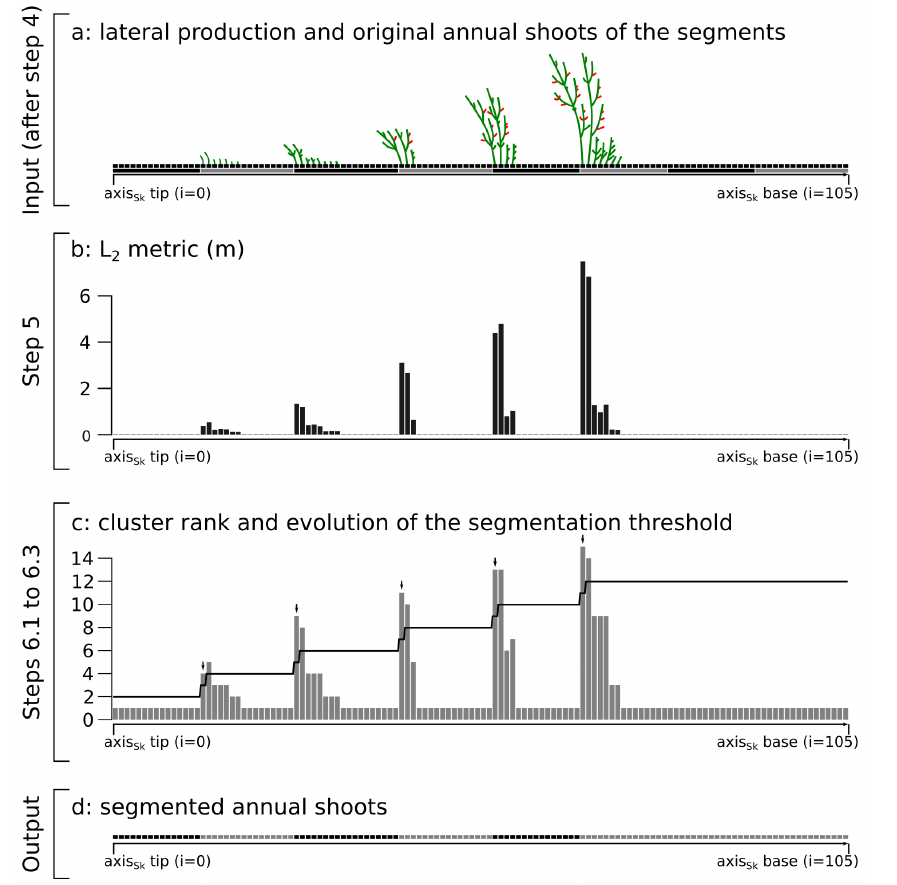
Figure 4. Illustration of the annual shoot segmentation along the trunk of an 8-year-old simulated tree composed of 105 segments. The input data ( a ) consists of a set of segments (dots of a dashed line), here presented with a schematic representation of their child axes Sk (with the axes Sk in green being used in the L 2 metric computation and those in red being excluded). Note that the annual shoots of the main axis are represented by a bicolour line for the purpose of clarity. The L 2 metric of each segment is then computed (bar height in ( b )). The segments are then grouped into clusters based on their L 2 metric, and the clusters are ranked by increasing order of L 2 metric (bar height in ( c )). An evolutive threshold (black line in ( c )) is then used to identify the tips of the annual shoots (arrows in ( c ). The output is the segmented annual shoots (shown in black and grey in ( d )). Note that the annual shoots located near the tree base are not segmented by the method as the trunk base is not branched (compare annual shoots in ( d ) to those in ( a )). Note that the steps indicated on the left of the figure correspond to the steps illustrated in Figure